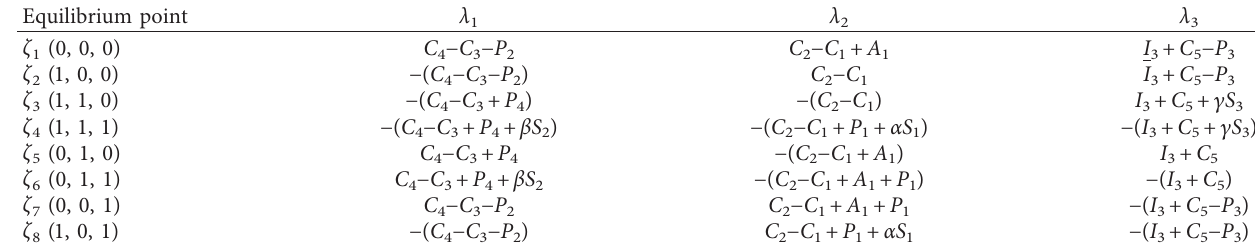
Table 3: Eigenvalues of the Jacobian